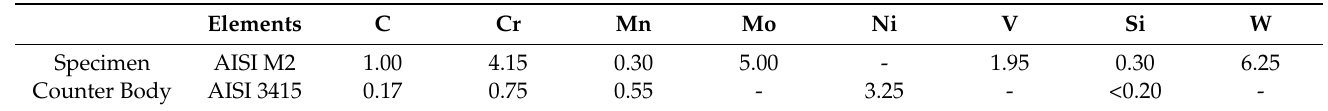
Table 1. Chemical composition of the specimens to be textured and coated and respective counter body (in weight